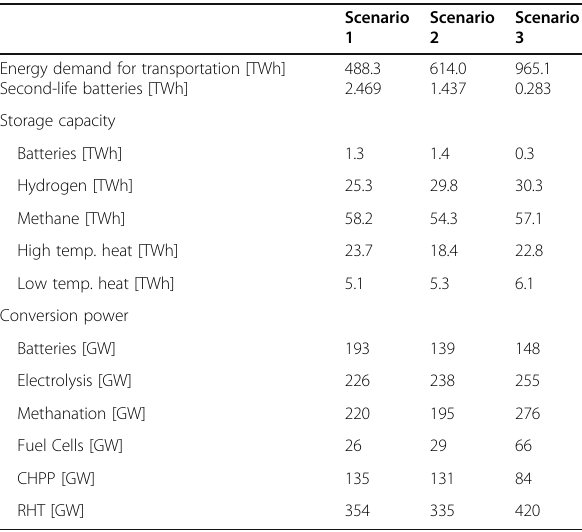
Table 2 (abstract P3).